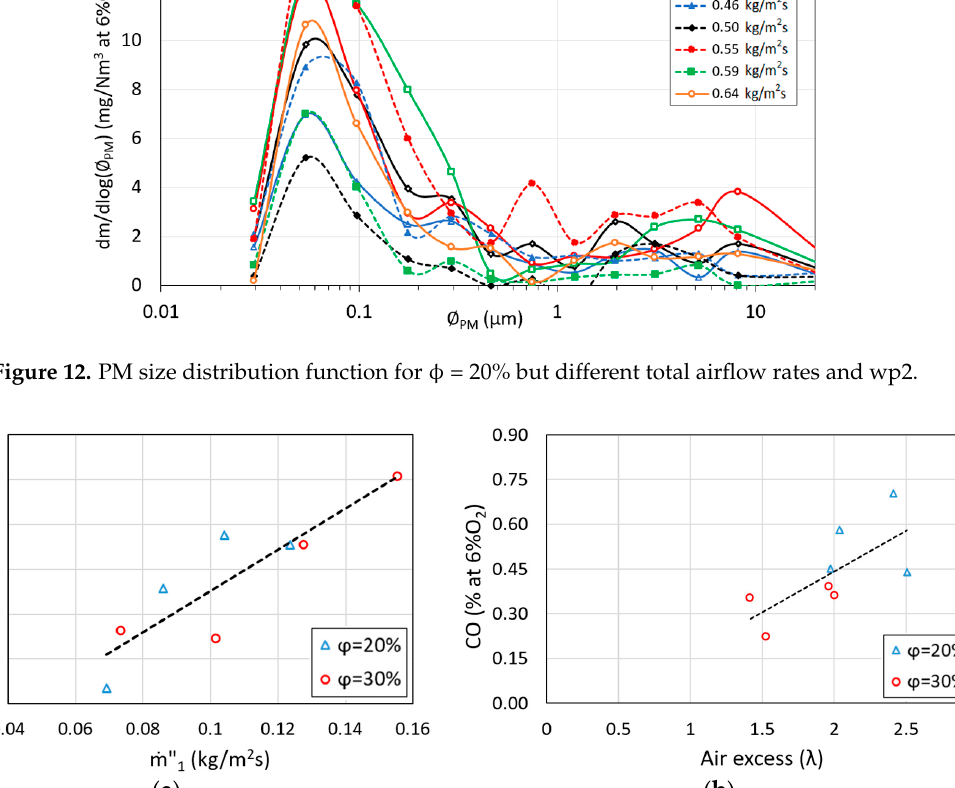
Figure 13. ( a ) Relation between NO X and primary airflow rate; ( b ) CO emissions versus air excess ratio.